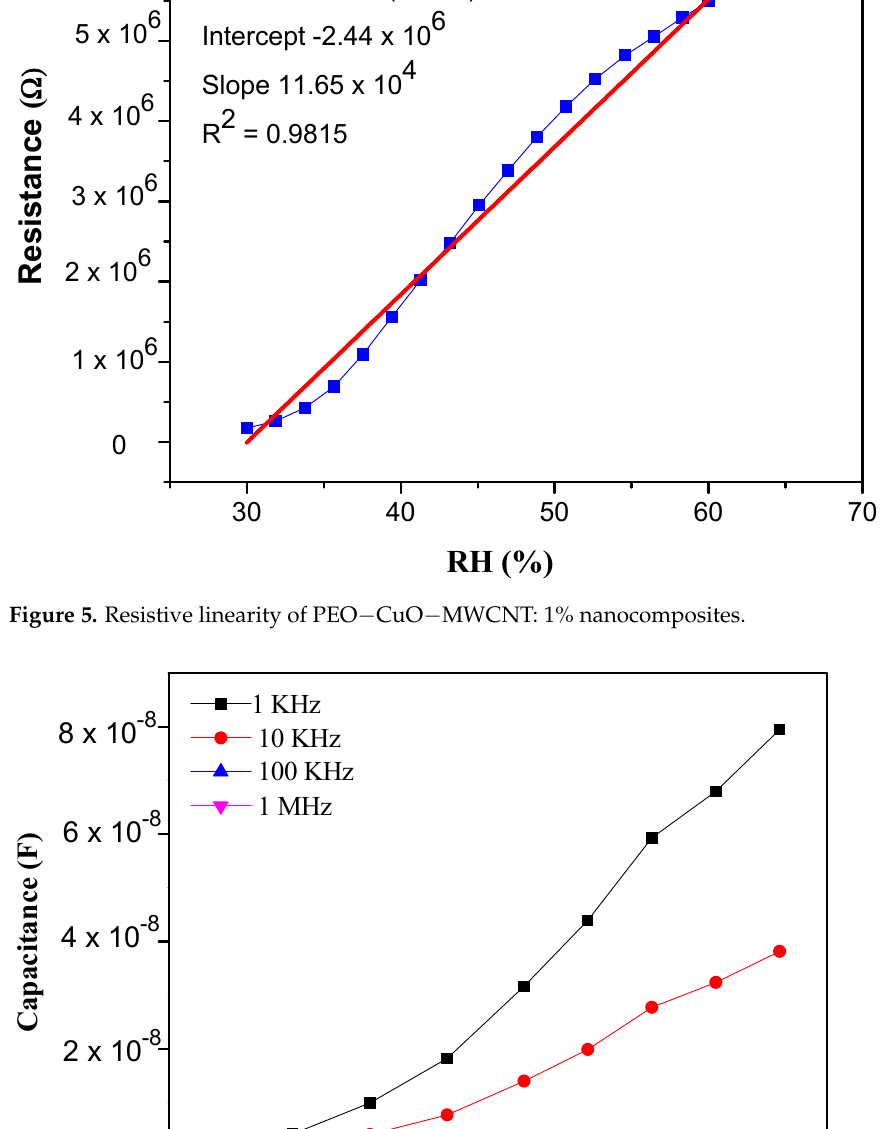
Figure 4. Resistivity Sensitivity of PEO-CuO-MWCNT:1% nanocomposite at different % RH.